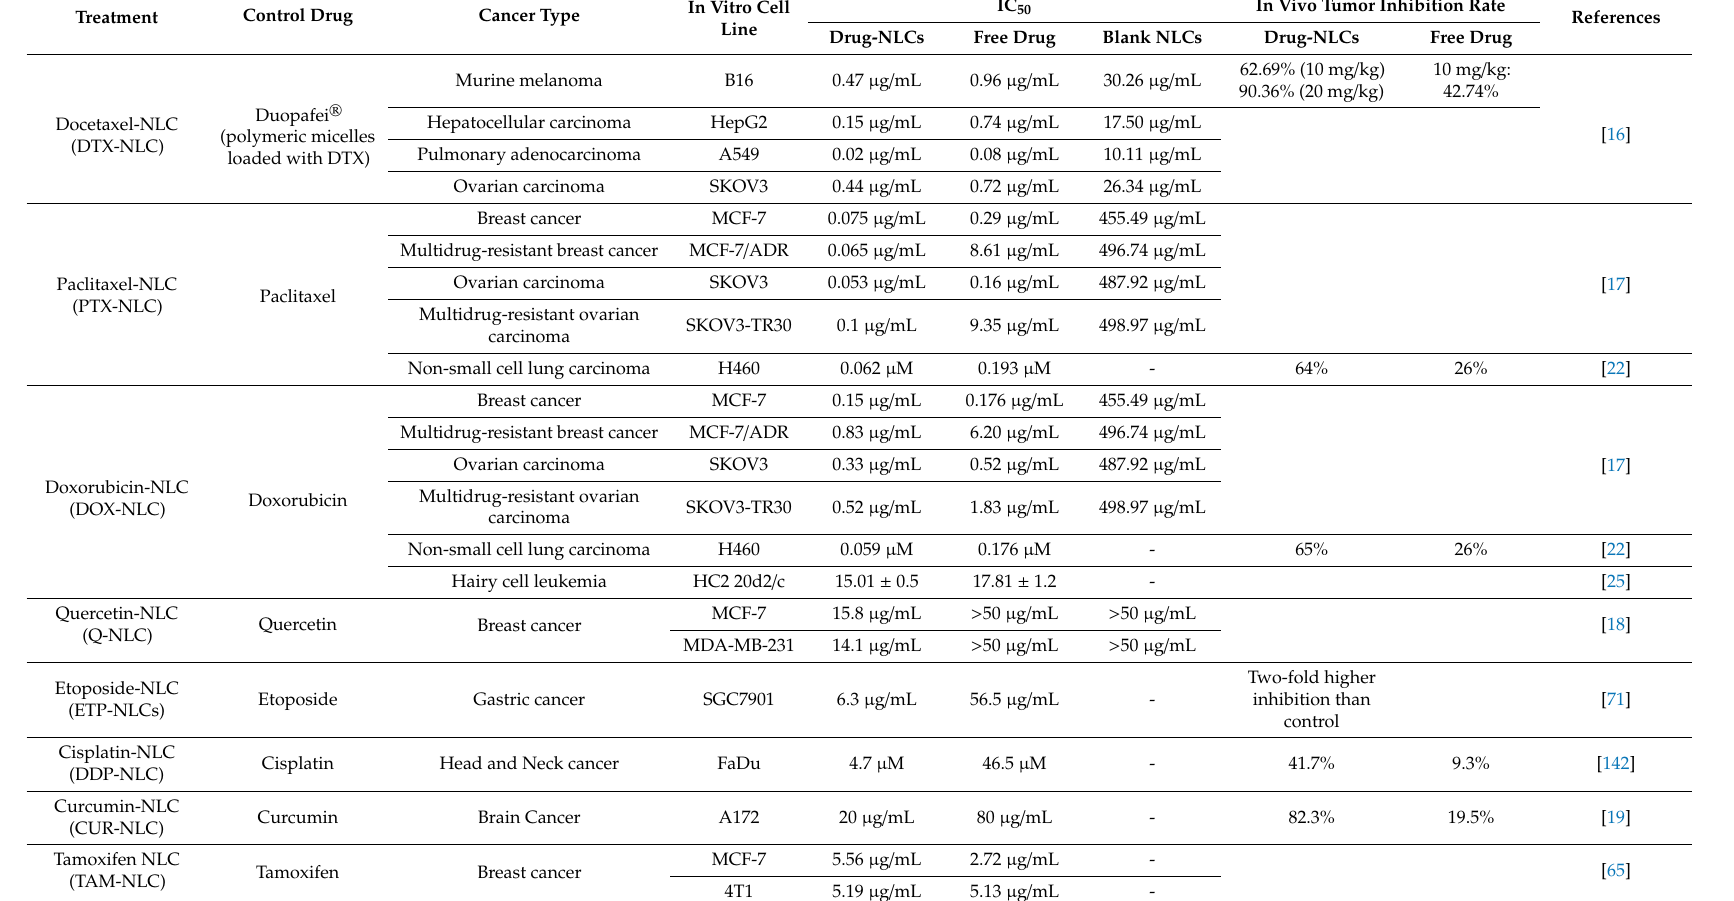
Table 3. Examples of NLCs as carriers for chemotherapeutic